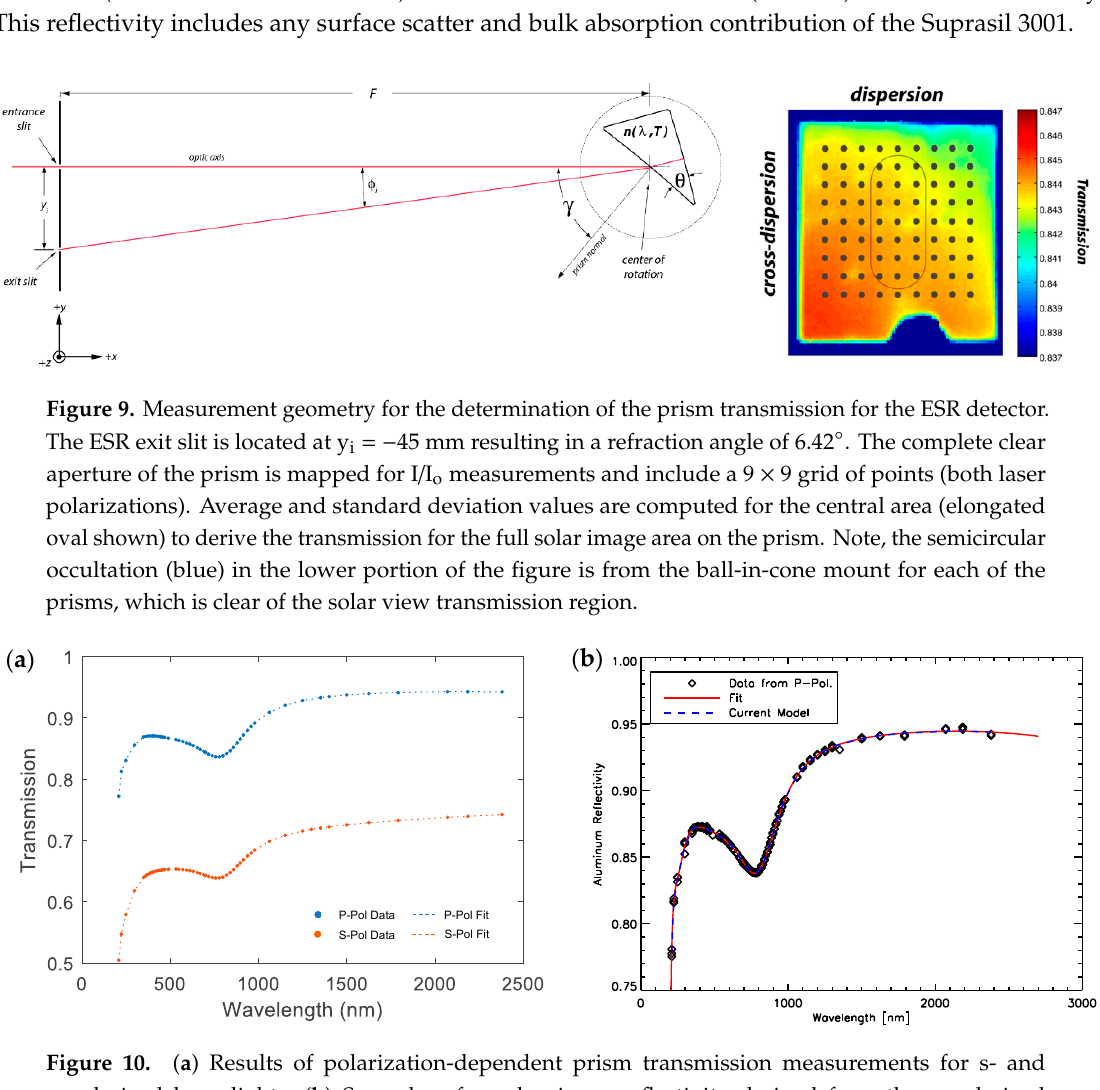
Figure 11. Plot of the measurement equation spectrally dependent corrections. These represent the known “photon-loss” factors that must be accounted for in deriving the true SSI from the measured detected power at the ESR (see text).